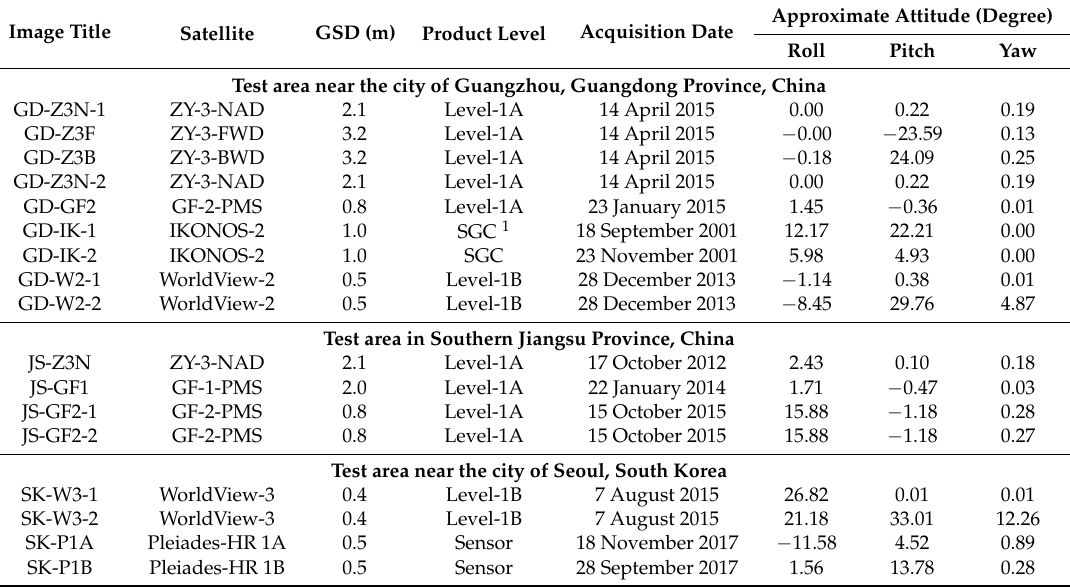
Table 1. The meta-information of the satellite